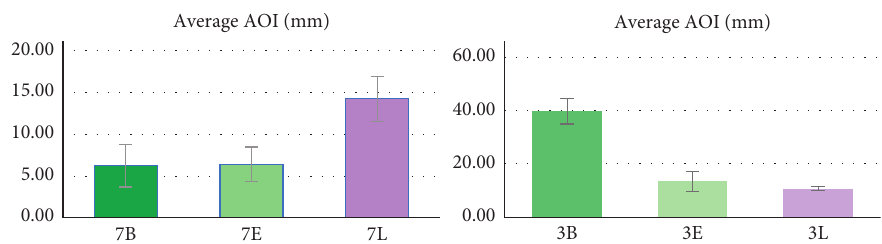
Figure 8: Results of repeated trials in Spring 2019 for treatment with lavender, basil, and eucalyptus oils.